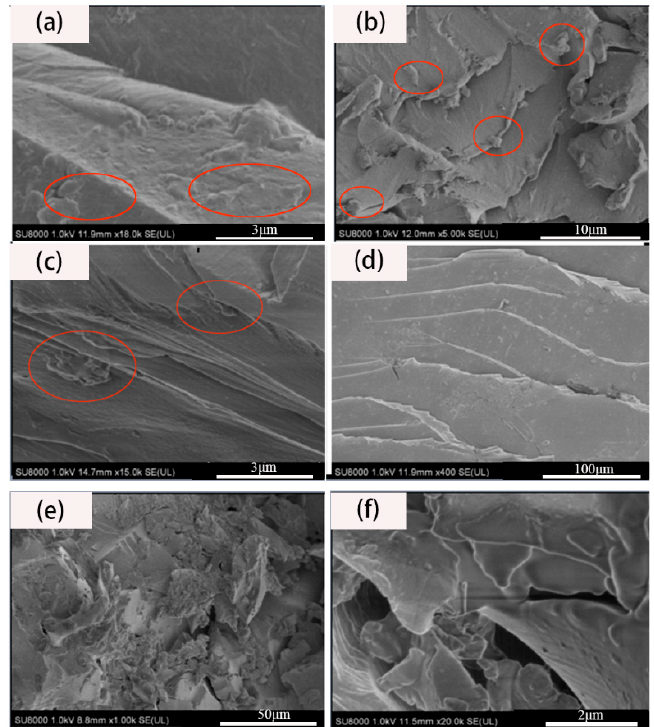
Figure 9. SEM images of the fracture surfaces of the composites: ( a ) modified GE/EP-0.03, ( b ) modified GE/EP-0.05, ( c ) modified GE/EP-0.07, ( d ) modified GE/EP-0.1, ( e ) CB/EP-0.4, ( f ) Ag/EP-20.